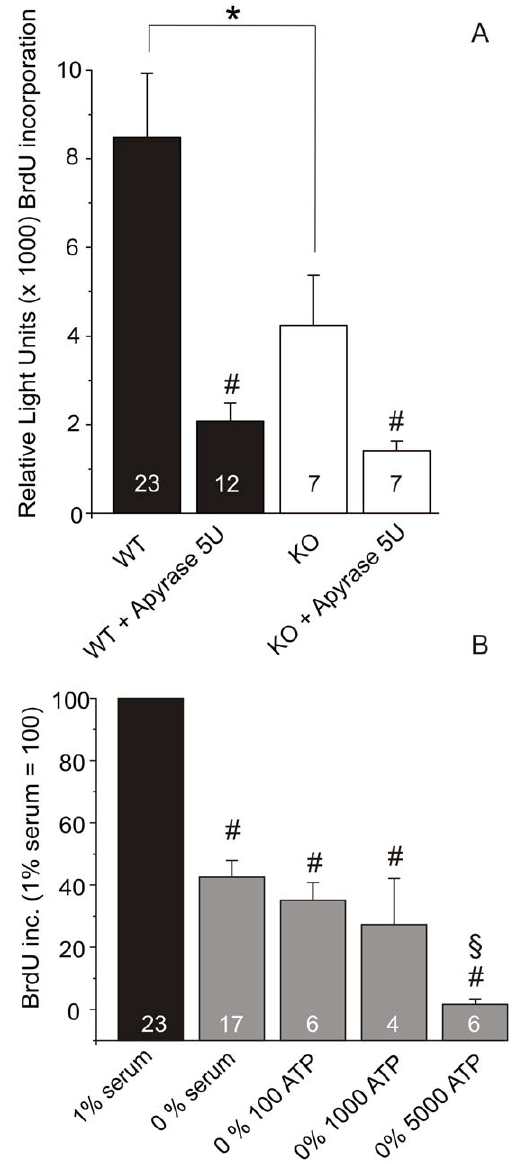
Figure 6. Effect of endogenous ATP and serum on PSCs proliferation. A. Comparison of the DNA incorporation in WT and KO PSCs with and without 5 U/ml apyrase. All samples contained 1% serum (n=9–23). Y-axis shows the BrdU incorporation in relative light units. In the presence of apyrase, there was no significant difference between proliferation of WT and KO cells. Significant difference (P , 0.05) from respective controls ( # ) and between WT and KO (*) is indicated. B. Effect of serum on DNA incorporation in WT PSCs. Significant difference (P , 0.05) from 1% serum controls ( # ) and between 0% and 0% serum with 5 mM ATP ( 1 ) is indicated.